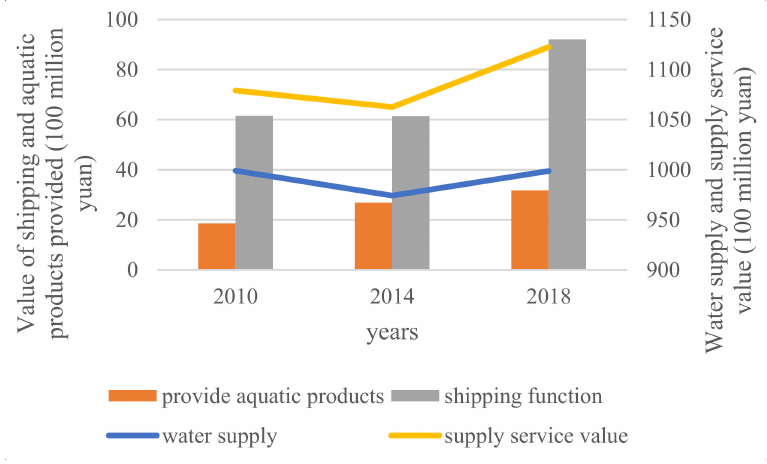
Figure 4. Provisioning service